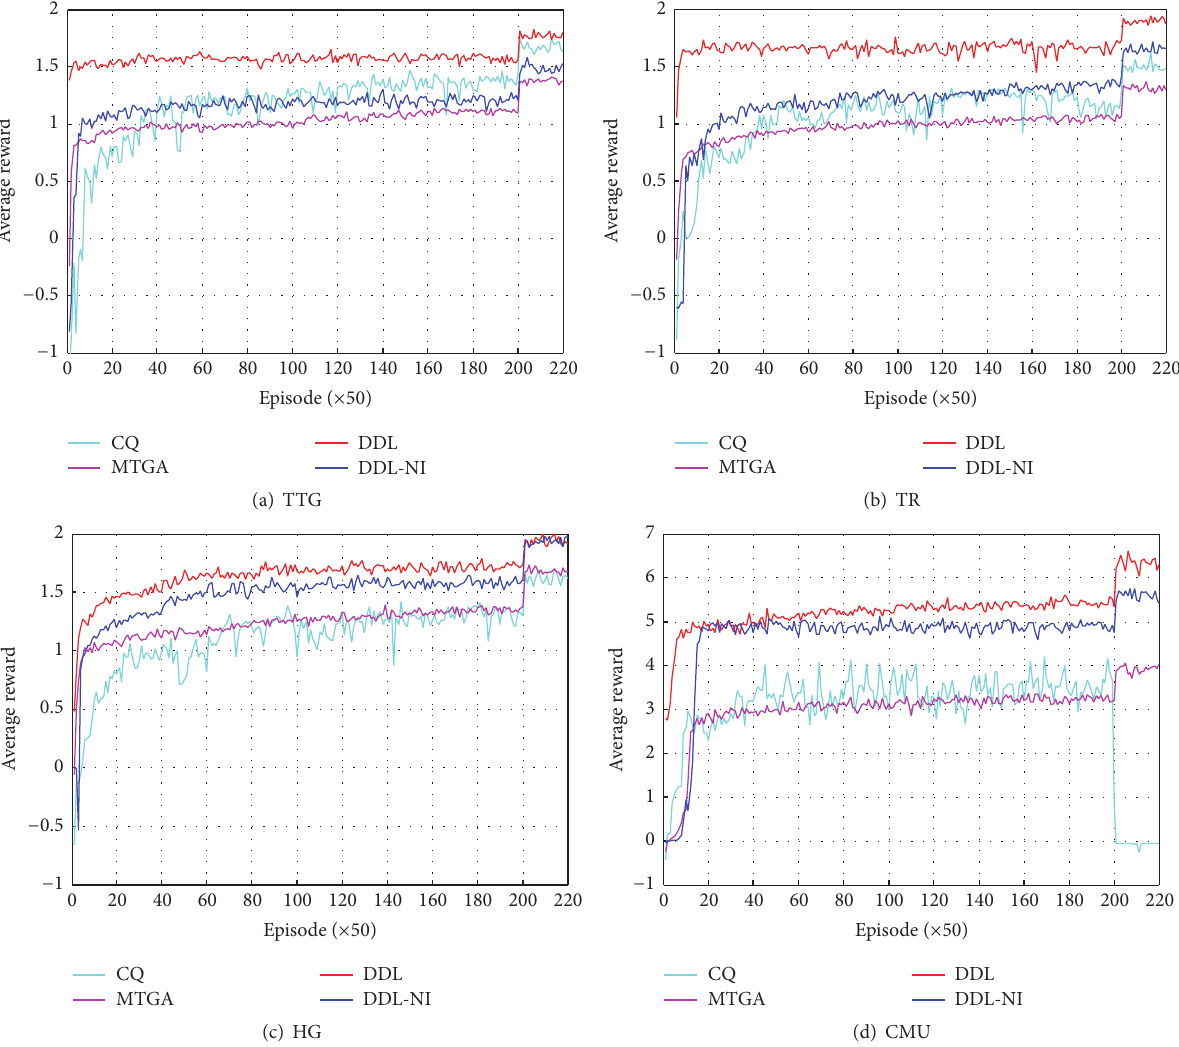
Figure 6: The learning curves of the tested approaches in games TTG, TR, HG, and CMU when 𝜌 = 0.8 and 𝜎 = −10 .